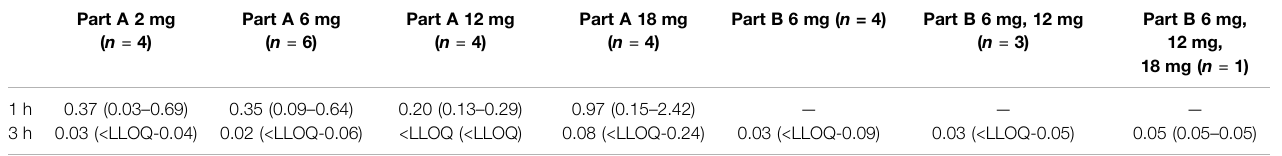
TABLE 3 | Mean (range) of 5-MeO-DMT (ng/ml) concentrations at 1 and 3 h after administration. Part A 2 mg ( n =